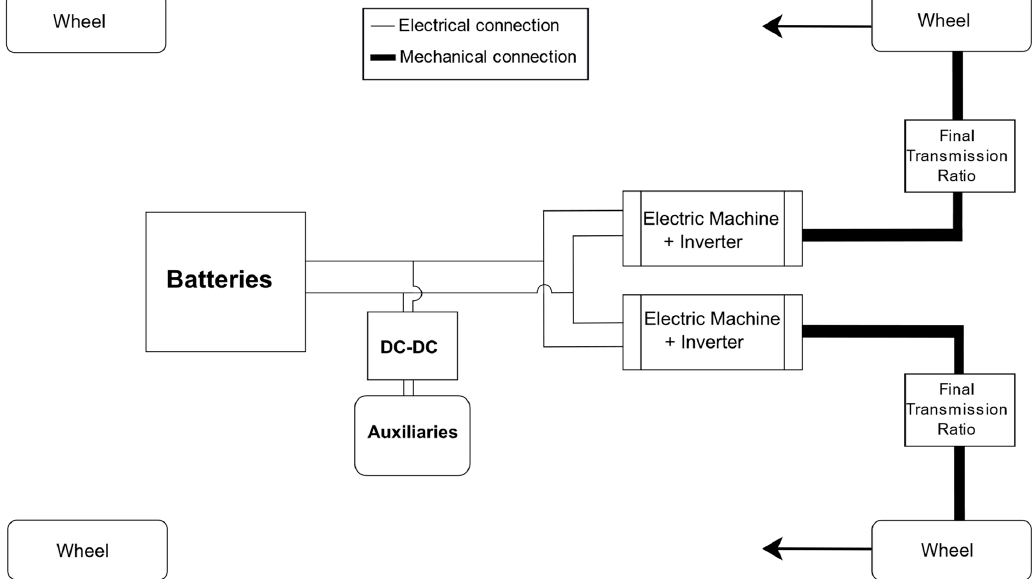
Figure 5. Configuration of the Electric Urban Bus.